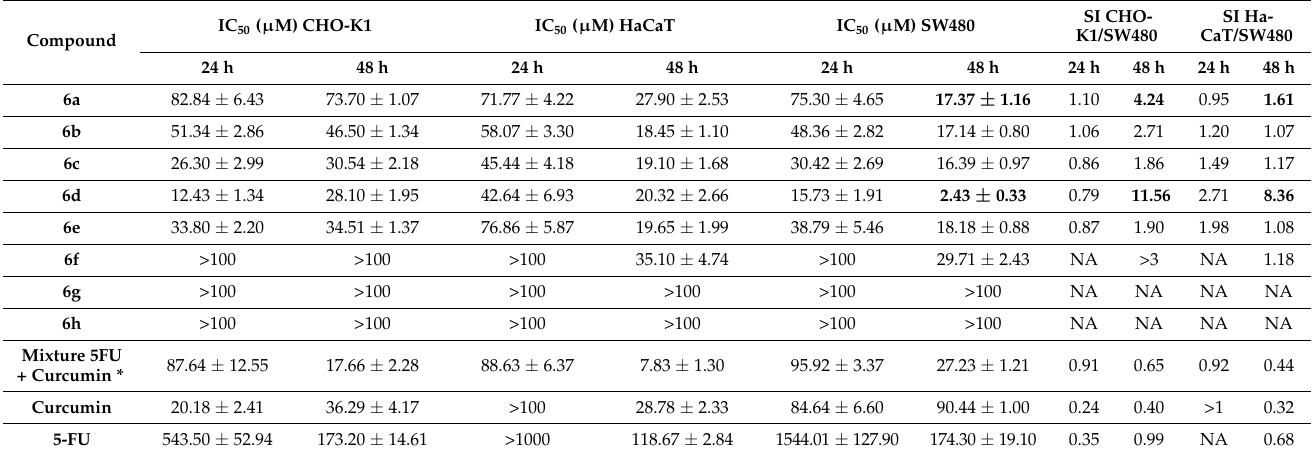
Table 1. Cytotoxic effect of 5-FU/Curcumin hybrids on SW480, HaCaT, and CHO-K1 cell lines.